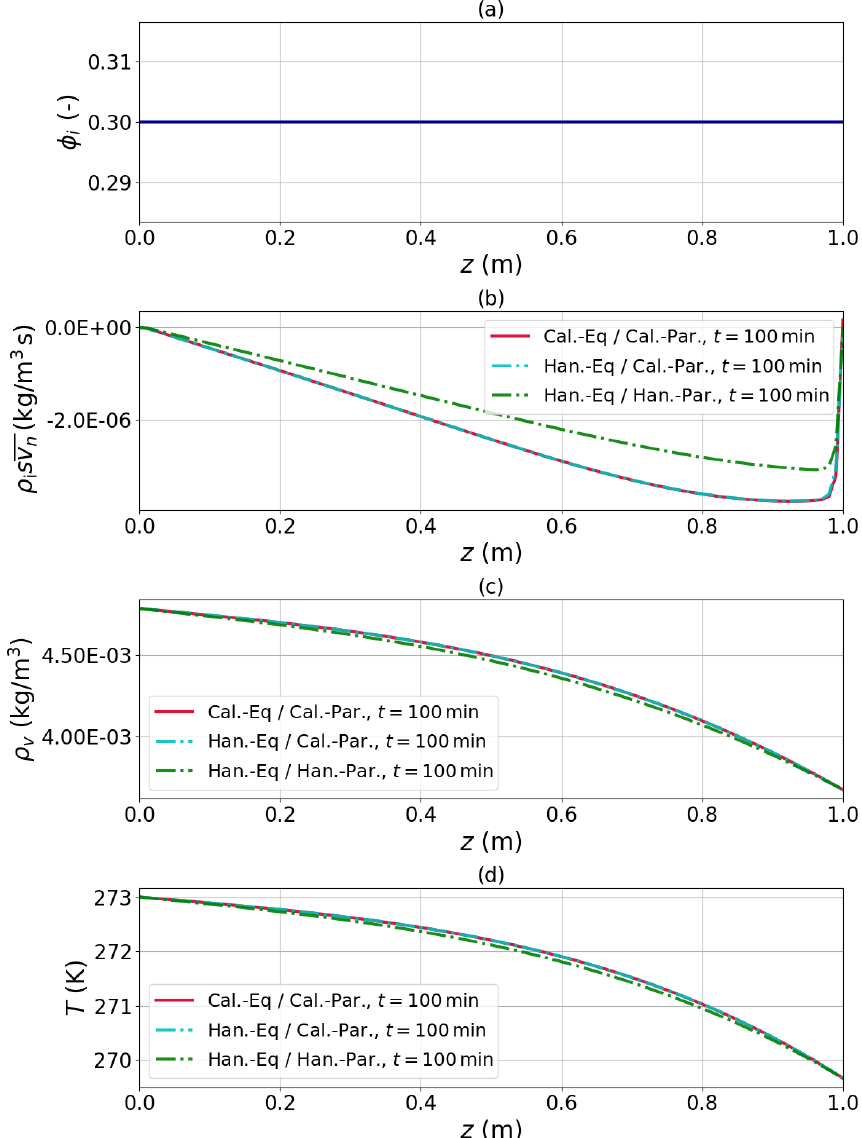
Figure 1. Comparison of Calonne’s and Hansen’s model for the response to a transient temperature decrease at the boundary without ice- phase evolution: slight differences are observed if the models are used with their own formulation of coefficients (red and green line), while both yield virtually indistinguishable results if the same coefficients are used (red and turquoise